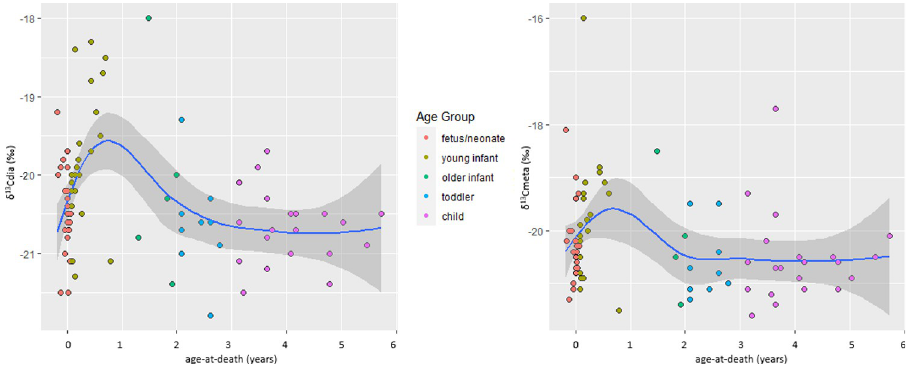
Fig 8. δ 13 C values of � 6-year-olds from Beemster. A) Diaphyseal values, B) metaphyseal values. The blue line is the best-fit smoothed (local) regression line (using loess algorithm) and the grey bands are the 95-percent confidence